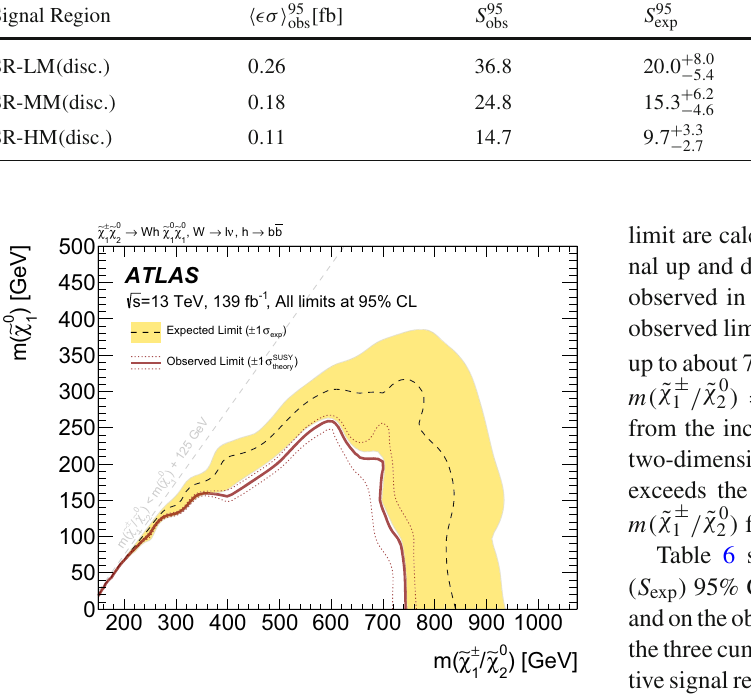
the SM prediction is observed in data. Figure 5 shows the post-fit m CT distributions in SR-LM, SR-MM, and SR-HM. The uncertainty bands include all statistical and systematic uncertainties. The dashed lines represent the benchmark sig- nal